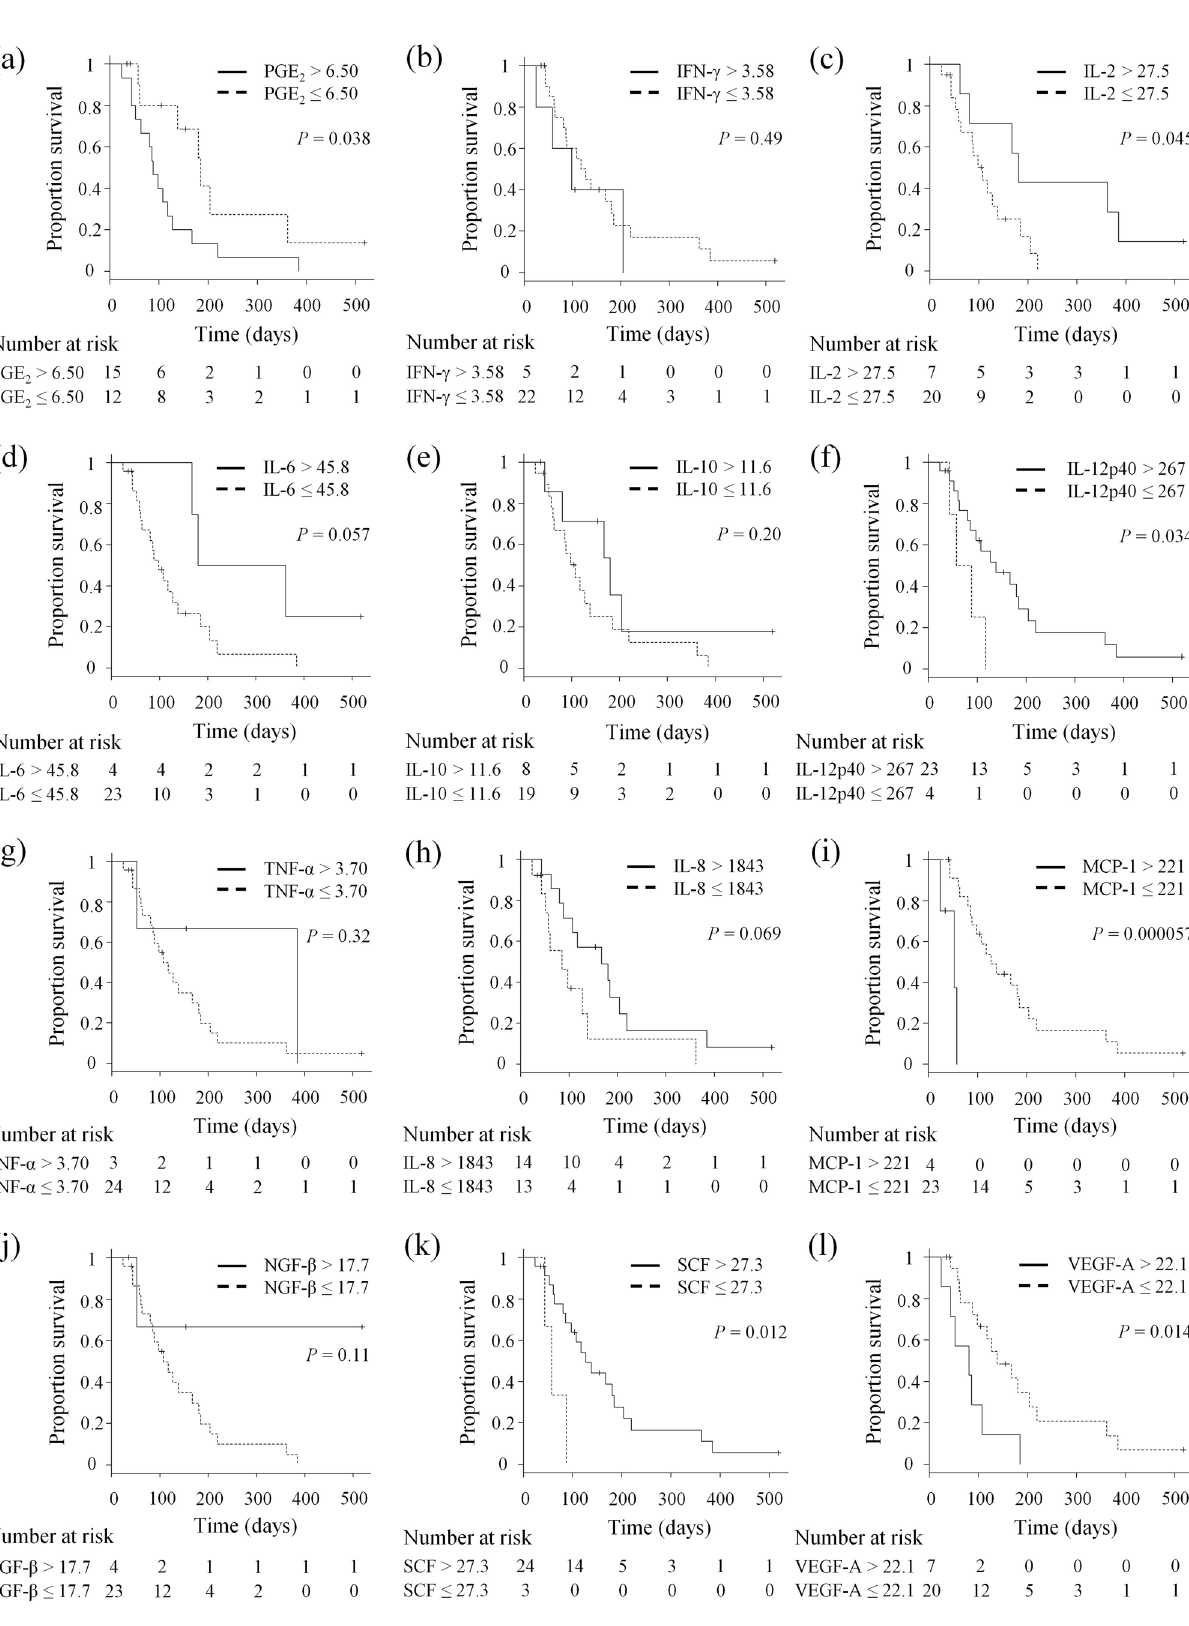
Figure 2. Baseline serum concentrations of several immune modulators are associated with overall survival (OS) in dogs with pulmonary metastatic OMM receiving c4G12 therapy. Dogs were dichotomized into subgroups based on the indicated cutoff value for ( a ) Prostaglandin E2 (PGE 2 ), ( b ) interferon-γ (IFN-γ), ( c ) interleukin (IL)-2, ( d ) IL-6, ( e ) IL-10, ( f ) IL-12p40, ( g ) tumor necrosis factor-α (TNF-α), ( h ) IL-8, ( i ) monocyte chemotactic protein 1 (MCP-1), ( j ) nerve growth factor-β (NGF-β), ( k ) stem cell factor (SCF), and ( l ) vascular endothelial growth factor-A (VEGF-A), and Kaplan–Meier curves were constructed comparing each corresponding subgroup (high group > cutoff vs. low group ≤ cutoff). Statistical analysis was performed using log-rank